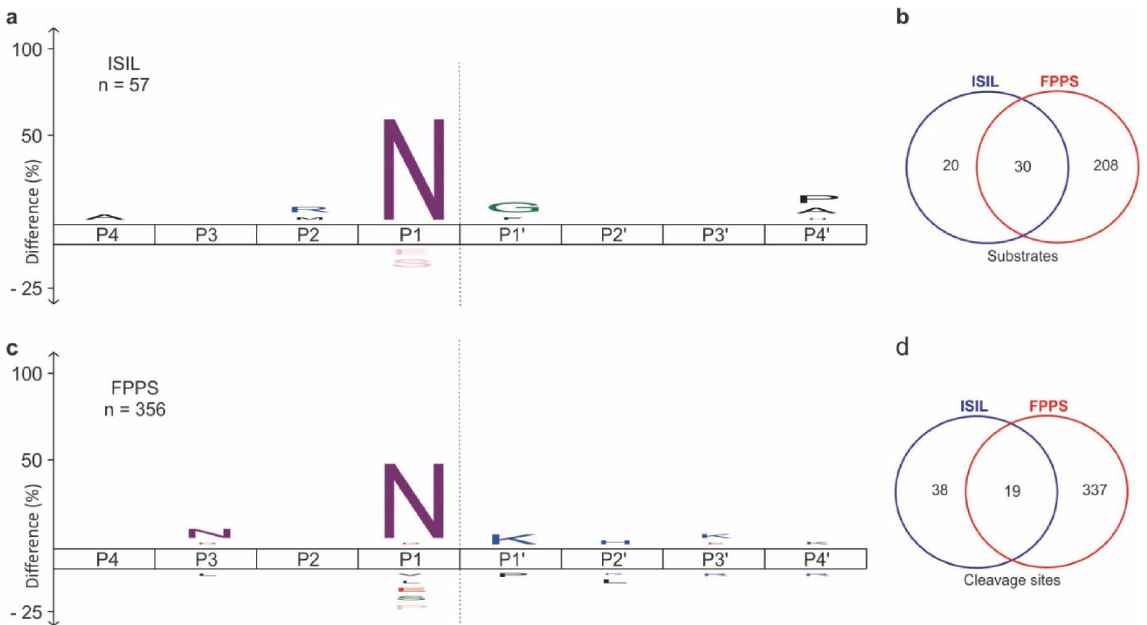
Figure 1. Legumain cleavage specificity profiling. (a) ISIL and (c) FPPS specificity profile of legumain for P4 to P4᾽ positions presented as iceLo- go 21 with the representative number of determined cleavages used for the iceLogo construction (n-value). Venn diagrams of unique and shared legumain (b) substrates and (d) cleavages sites between ISIL and FPPS